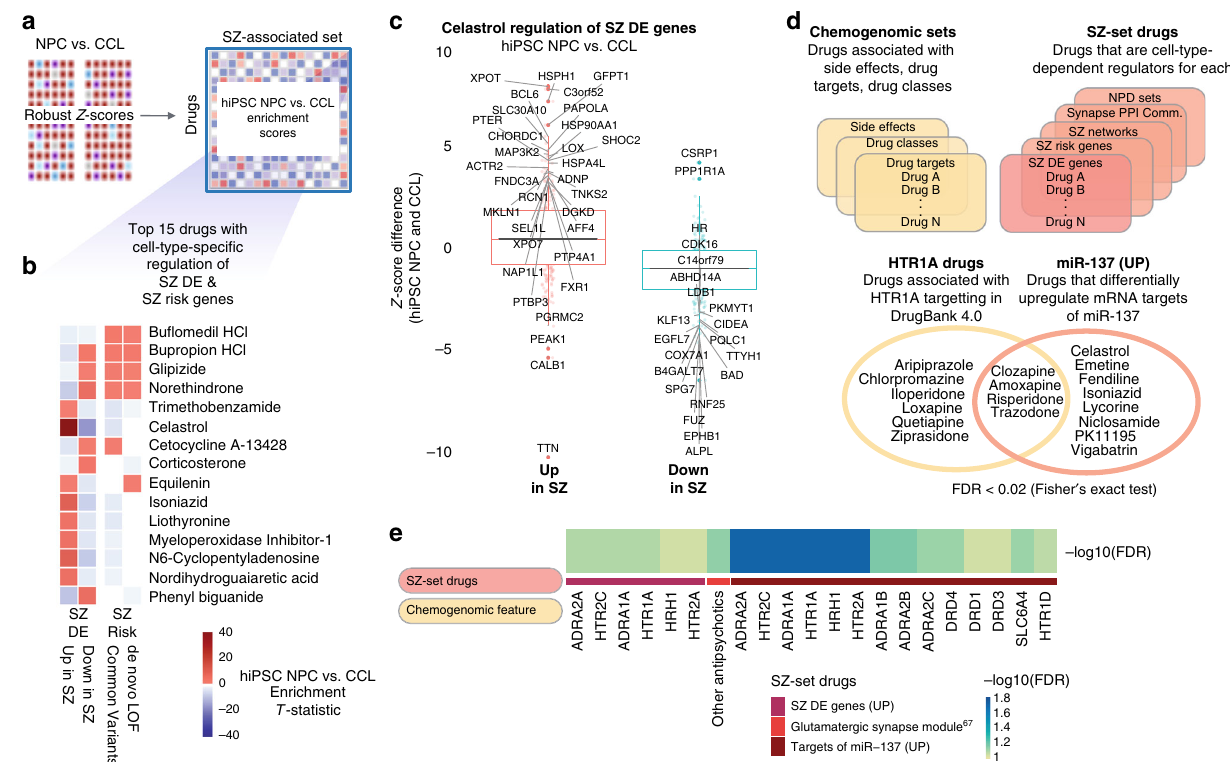
Fig. 4 Differences in drug-induced responses between hiPSC NPCs and CCLs. a A gene-set enrichment approach was applied to identify drugs that regulated expression of SZ-set genes differently in pro fi les generated from hiPSC NPCs and CCLs. b Top 15 drugs with highest collective cell-type-speci fi c perturbation of genes differentially expressed in prefrontal cortex of individuals with SZ (SZ DE), and/or genes harboring common and de novo SZ-risk- associated variants. Squares with enrichment FDR > 0.1 are shown as white. c Celastrol showed strong hiPSC NPC/CCL differential regulation of SZ DE genes (absolute Z-score difference > 3 labeled as solid fi lled circles with dark red or blue color). d To identify pharmacological features associated with drugs that differentially perturbed SZ sets in hiPSC NPCs compared with CCLs, we performed a chemogenomic enrichment analysis. SZ sets that were differentially perturbed by at least three drugs in the study (SZ-set drugs) were identi fi ed and enrichment testing was performed to identify over- represented drug targets, drug classes, and side effects. Drugs that differentially perturbed SZ sets between hiPSC NPCs and CCLs shared two pharmacological features: targeting of the serotonin receptor HTR1A and upregulation of the SZ-associated microRNA miR-137. e Chemogenomic features that were over-represented among drugs that differentially regulated various SZ sets depending on cell type (hiPSC NPC vs. CCL) context. Strong enrichment observed for drugs that differentially regulated SZ DE genes and targets of miR-137, particularly by antipsychotic drugs that targeted adrenergic, serotonergic, and dopaminergic neurotransmitter receptors (chemogenomic features). Abbreviations: SZ DE, genes differentially expressed in SZ; SZ Risk, genes harboring SZ-risk-associated loci; SZ Networks, SZ-associated coexpression networks; Synapse PPI Communities, NPD enriched synaptic protein seeded clique communities; and NPD Sets, diverse NPD-associated sets, e.g., miR-137